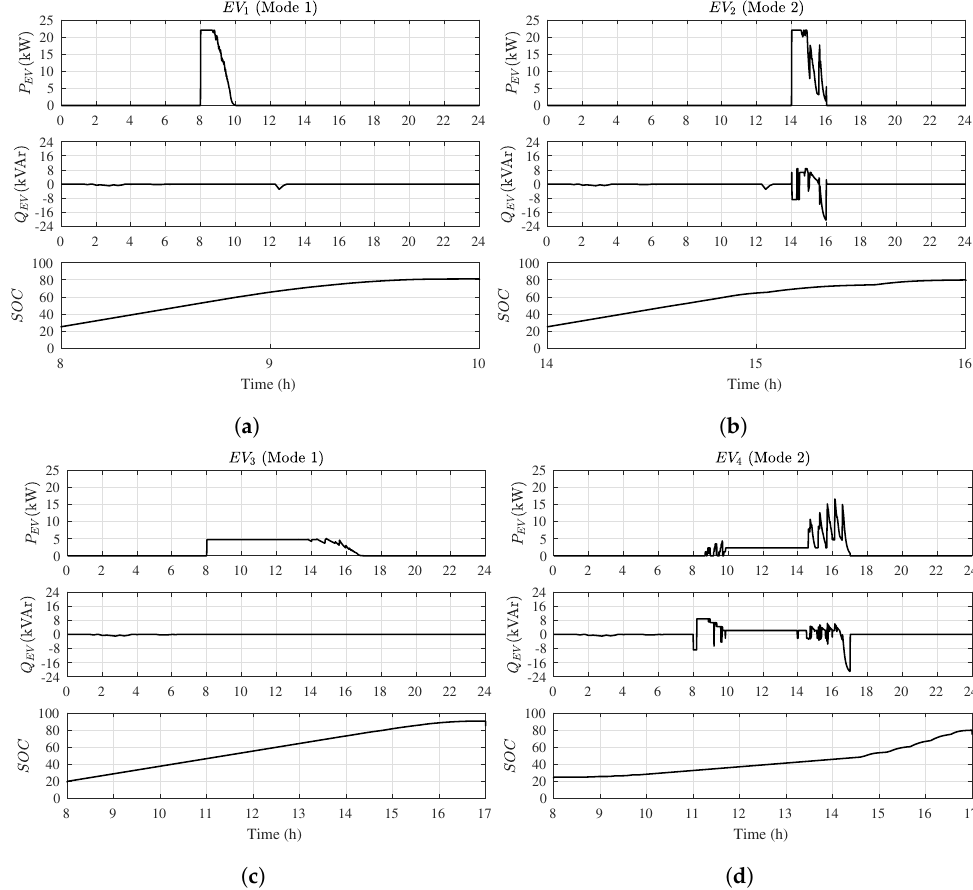
Figure 10. Active and reactive reference profiles and SOC of each vehicle in the scenario 1: ( a ) EV 1 , ( b ) EV 2 , ( c ) EV 3 and ( d ) EV 4